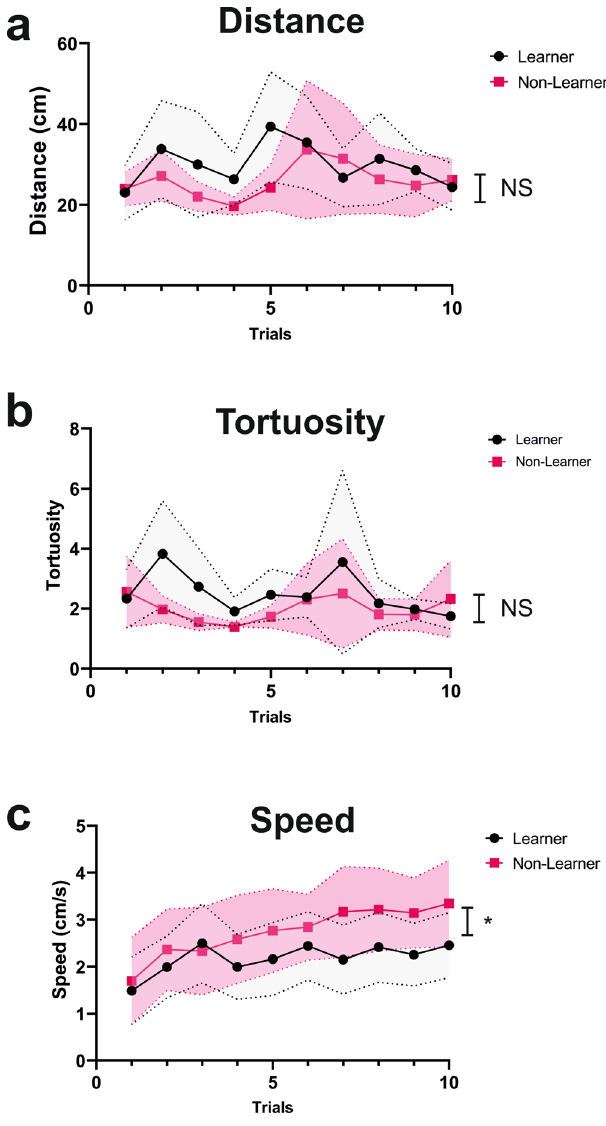
Fig. 4 Motor components of learners ( n = 17) and non-learners ( n = 18) in the VR setup during conditioning. a Distance travelled (cm) during each conditioning trial. b Tortuosity of the trajectories (see text for explanation) during each conditioning trial. c Walking speed (cm/s) during each conditioning trial. The dashed lines above and below the curves represent the 95% con fi dence interval. Comparisons between curves refer to the signi fi cance of the interaction between the factors Trial (1 – 10) and Condition (learners vs. non-learners). All comparisons referring to Condition alone were non-signi fi cant. LMM; * p < 0.05; NS non-signi fi